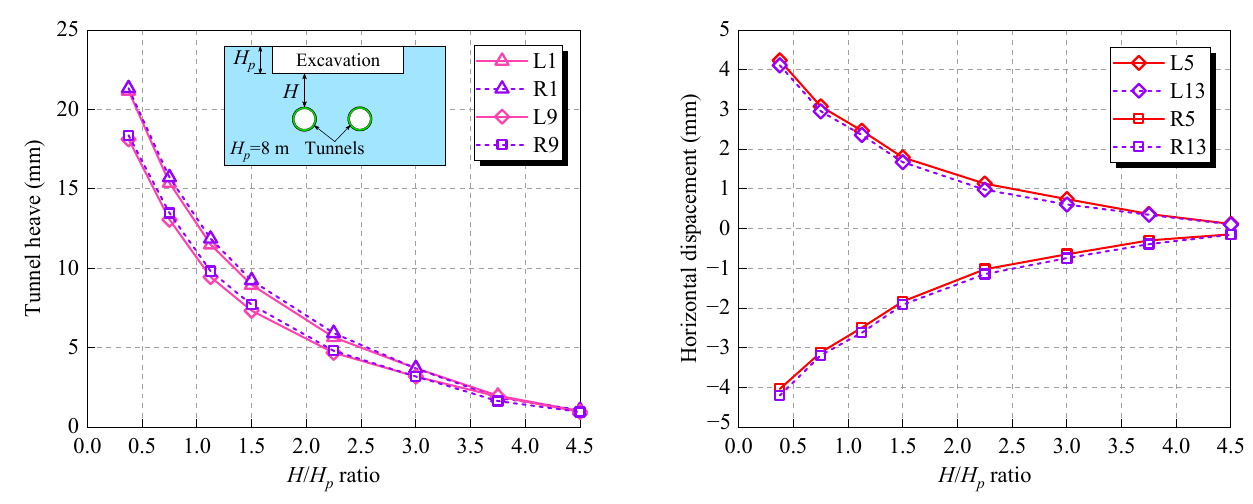
13 of 18 Figure 15. Comparison of earth pressure between numerical simulation and experimental test. 5.3. Effect of Cover-to-Depth Ratio As the clearance ( H ) between the bottom of the foundation pit and the crown of the tunnel increases, the impact on the tunnels caused by the excavation and unloading would gradually decrease. The tunnel displacement responses with variations of the H / H p ratios are analyzed in depth. The H values are set as 3 m, 6 m, 9 m, 12 m, 18 m, 24 m, 30 m, 36 m in the numerical runs, and the monitoring point arrangement is the same as Figure 5 de- scripted previously. Figure 16 shows the variations of tunnel heaves and horizontal dis- placements with different H / H p ratios after the excavation completed. The results confirm that both the tunnel heaves and horizontal displacements gradually decrease with the in-